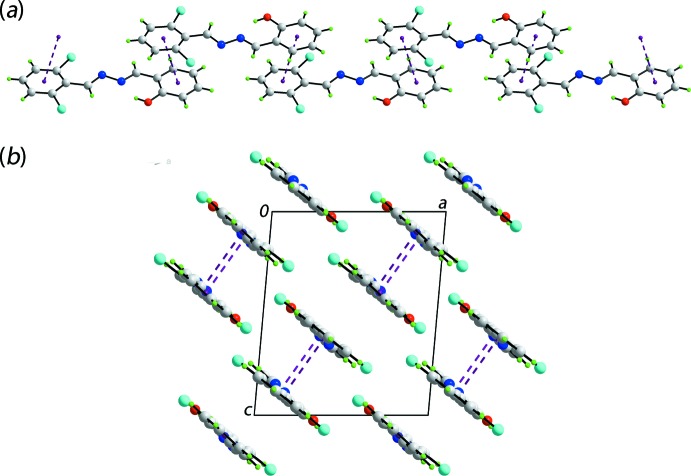
Mol­ecular packing in the crystal of (I): (a) supra­molecular chain sustained by π(hy­droxy­benzene)–π(chloro­benzene) inter­actions shown as purple dashed lines and (b) a view of the unit-cell contents in a projection down the b axis.